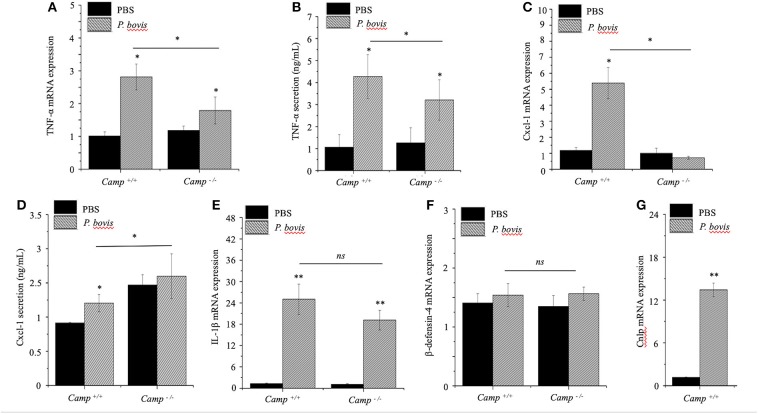
Lesser synthesis of pro-inflammatory cytokines in Camp−/− mice infected with Prototheca bovis. Camp+/+ and Camp−/− were intramammary challenged with P. bovis or PBS (control). Transcriptomic expression and protein secretion of pro-inflammatory genes in the mammary gland including (A,B)
TNF-α, (C,D)
Cxcl-1, (E)
IL-1β, (F) β-defensin-4, and (G)
Camp were determined at 4 d post-infection. mRNA synthesis was quantified using RT qPCR and protein secretion was determined in cell supernatant by ELISA. Data are means ± SEM (n = 4/group). *p < 0.05, **p < 0.01 (one-way ANOVA post hoc Bonferroni correction) was considered significant.